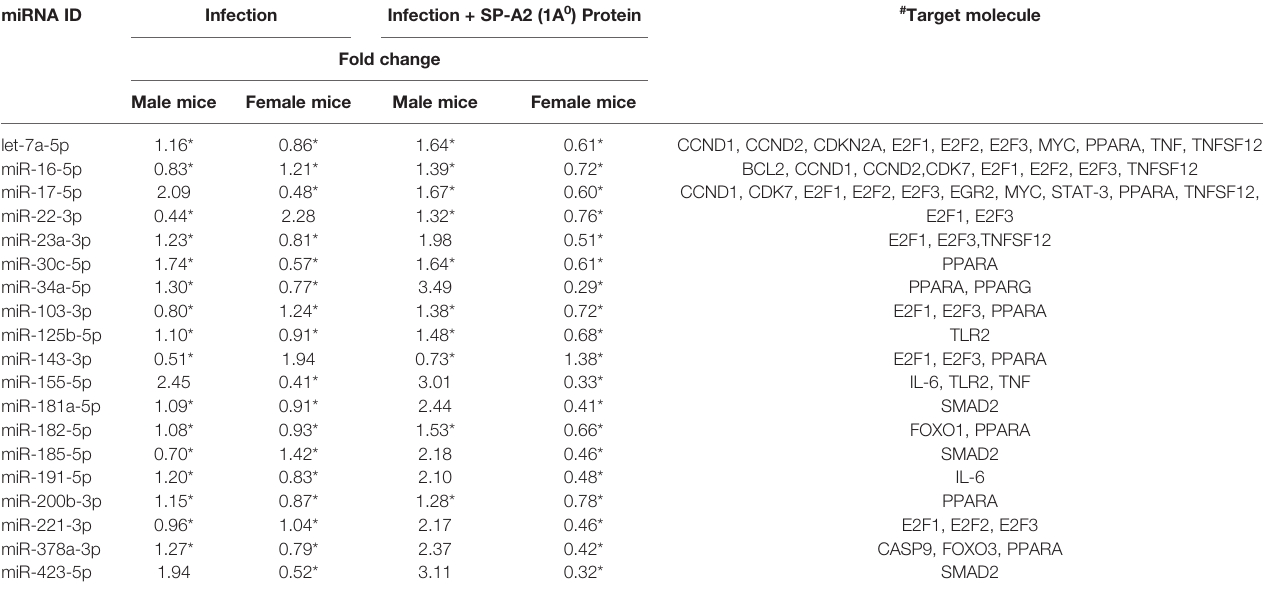
*Indicates downregulation. # Identi fi ed by IPA.